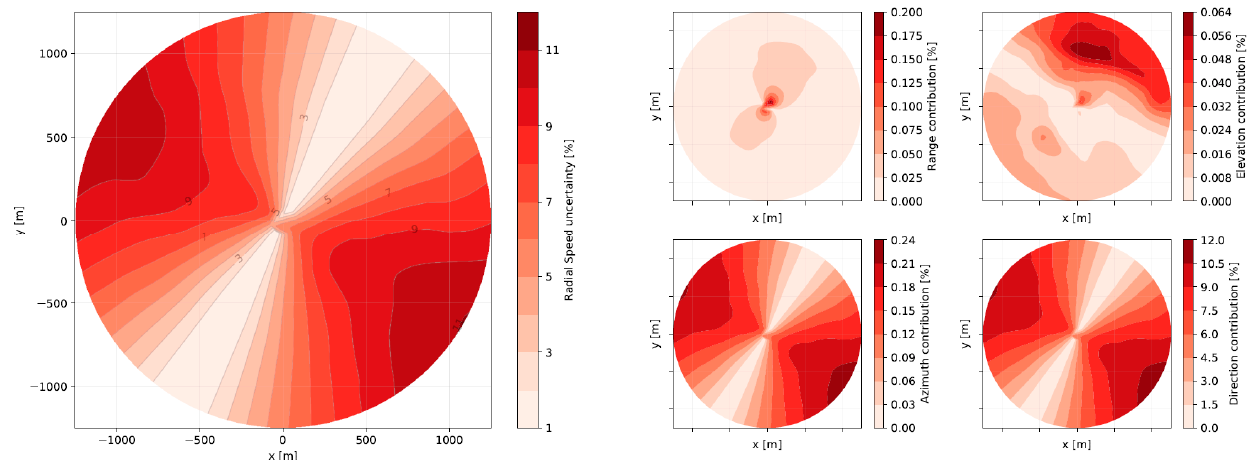
Figure A2. Analytically derived uncertainty contributions for LOS measurements of PPI scan—here for the flow case defined by 𝜑 = 210° and 𝛼 = 0.2 . Uncertainties are given as percentage values with respect to a reference wind speed normalized to 1.